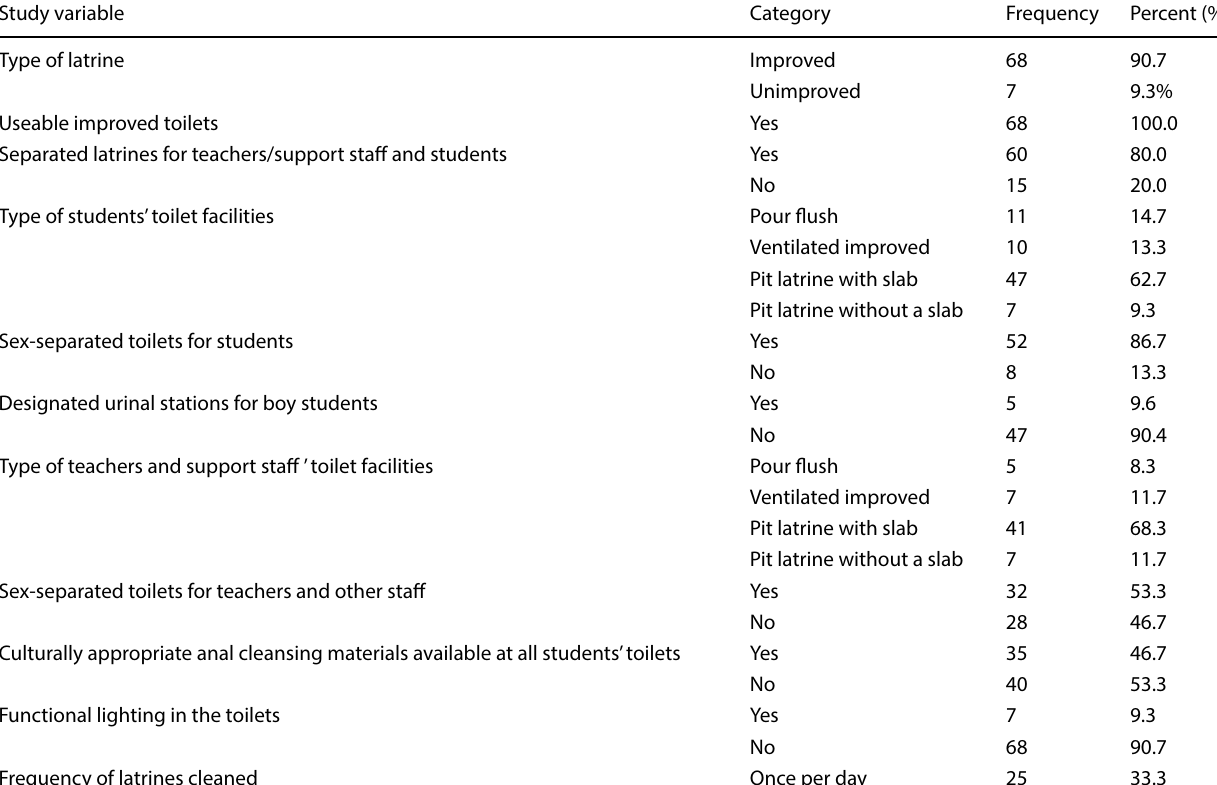
Table 3 Type of sanitation facilities and availability of menstrual hygiene services (n =